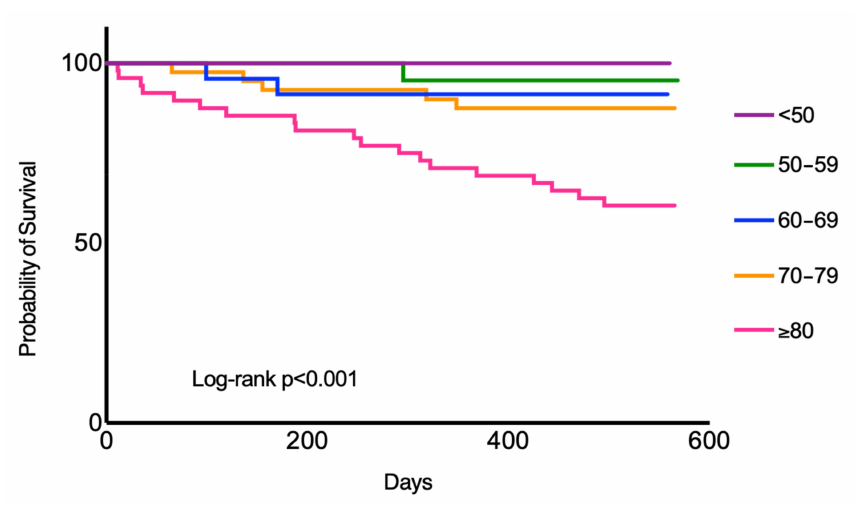
Figure 3. KM survival curve for age groups. The >80-year-old patients were much more likely to perish in the post-COVID period compared to their younger counterparts (HR 3.7 [1.7–8.2], p <